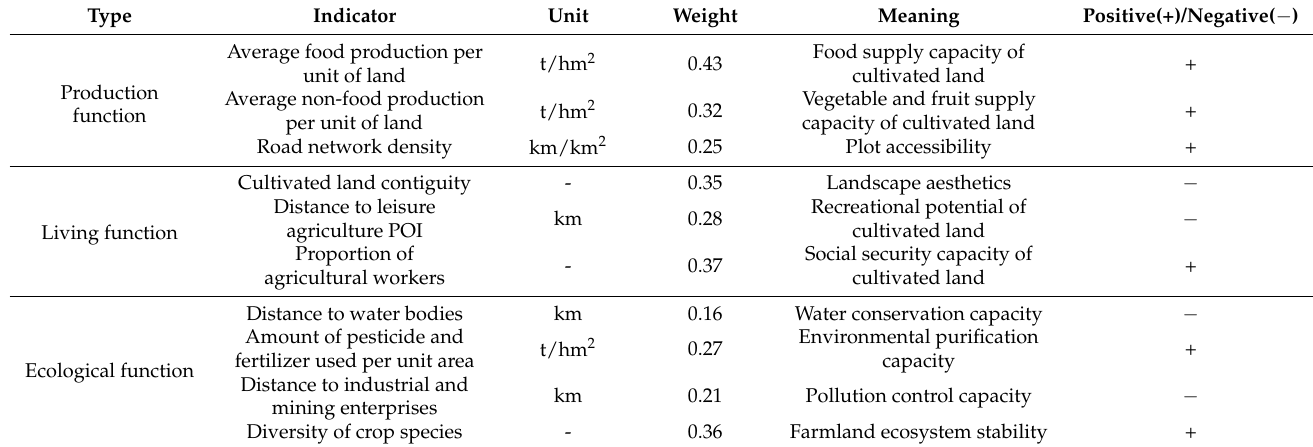
Table 2. Evaluation index system and weights of CLUFs in Yuanyang County.